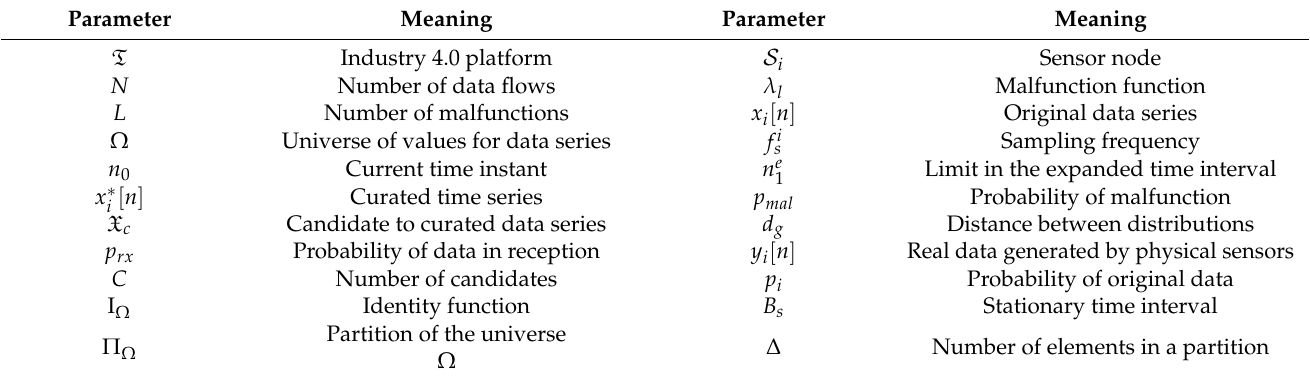
Table 1. Most relevant symbols and